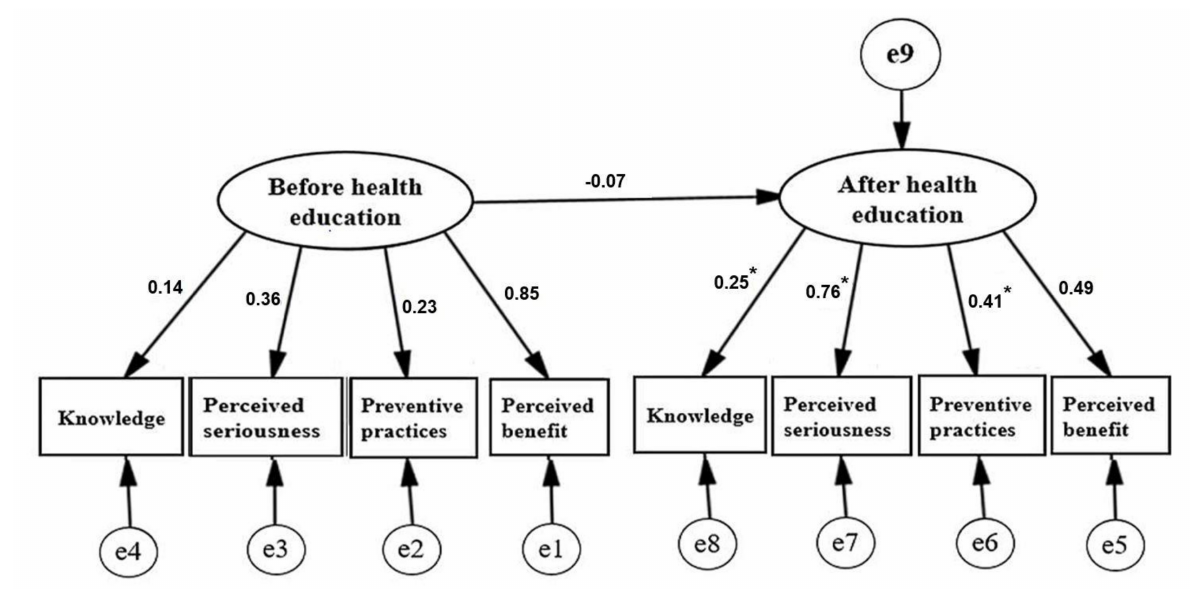
Figure 1. Path analysis for knowledge, perceived seriousness, perceived benefit, and preventive practice from before to after implementing the health education program. Note: The numbers in the figure represent path coefficients, the parameters that affect the size of the independent variable on the dependent variable. e1–e9: measurement errors. * p < 0.05.